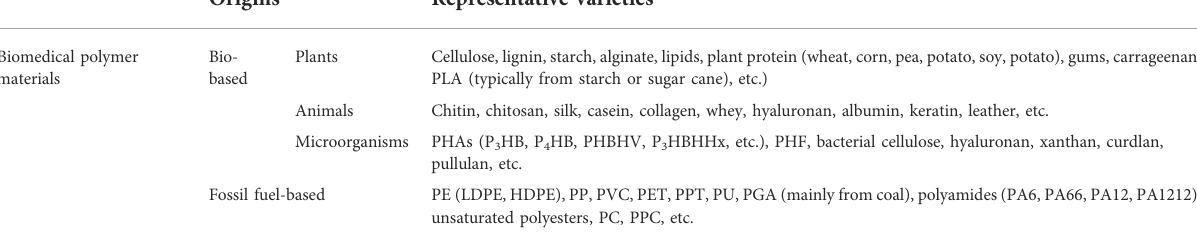
TABLE 1 Classi fi cation of biomedical polymer materials with different origins.